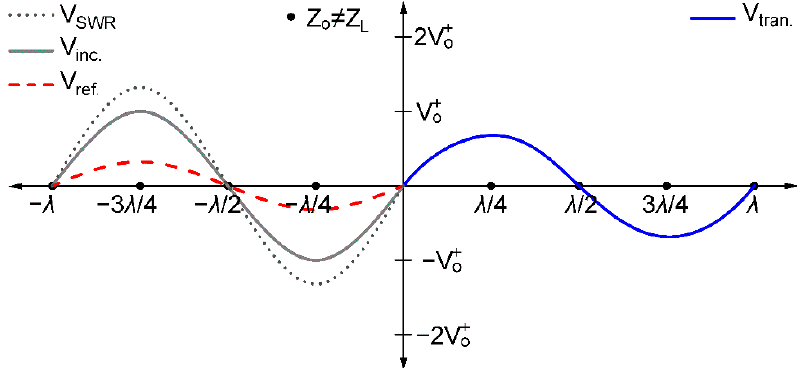
Figure 1. Transverse electromagnetic wave characteristics of a transmission line at an instant time for impedance mismatch. The voltage standing wave (V SWR ) is formed due to the superposition between the incident (V inc. ) and reflected (V ref. ) waves, while the transmitted (V tran. ) wave amplitude is reduced.